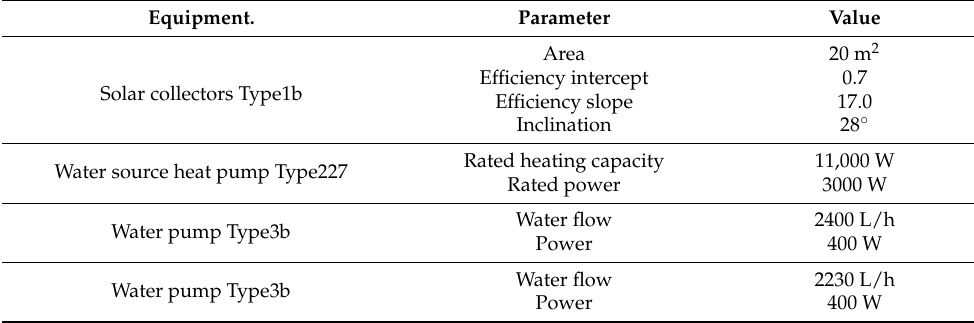
Table 5. Parameter settings of equipment.